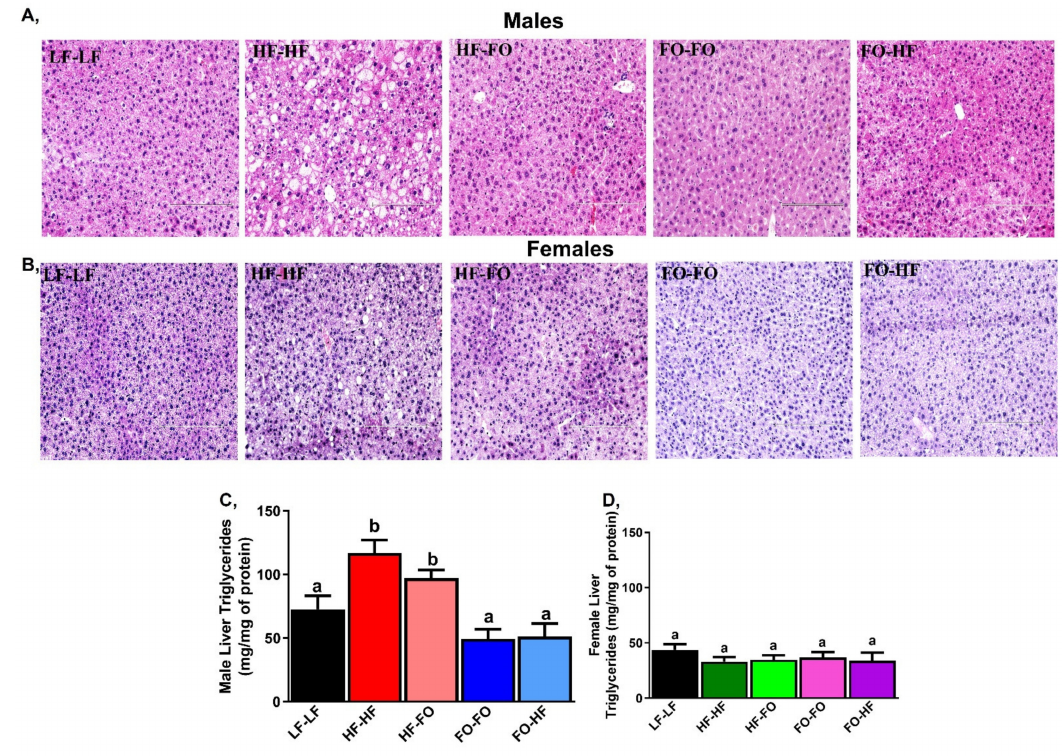
Figure 8. Fish oil role in liver in males and females. ( A , B ) Haematoxylin and eosin (H&E) staining images for liver from male and female mice (20x magnification and 200 µ m scale) ( C , D ) Liver triglycerides measured by calorimetry was lower in males and females. Data is presented as mean ± SEM (n = 4 for H&E staining and n = 8–13 liver triglycerides). Common letters on the error bars indicate no significance (e.g., “a” is significantly different from “b” and “ab” indicates no significance compared to “a” and